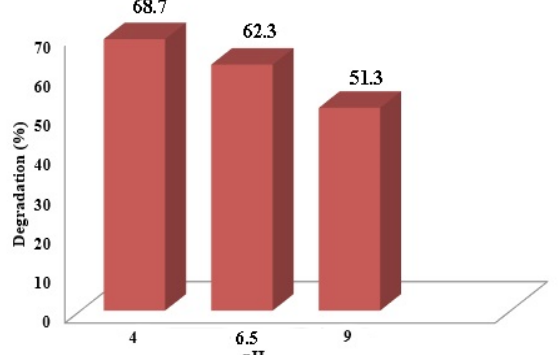
Fig. 7. Photo-catalytic degradation of methyl orange: effect of initial pH